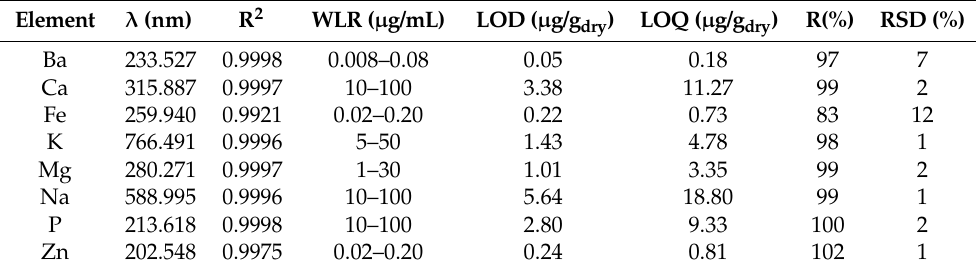
Table 1. Working linear range (WLR), determination coefficient (R 2 ) and limit of detection (LOD) and quantification (LOQ) related to the analytical calibration curve of the elements (with corresponding detection wavelength, λ ) determined by ICP-OES. Mean recovery (R) and relative standard deviation (RSD) observed in the analysis of the enriched samples (n = 6).